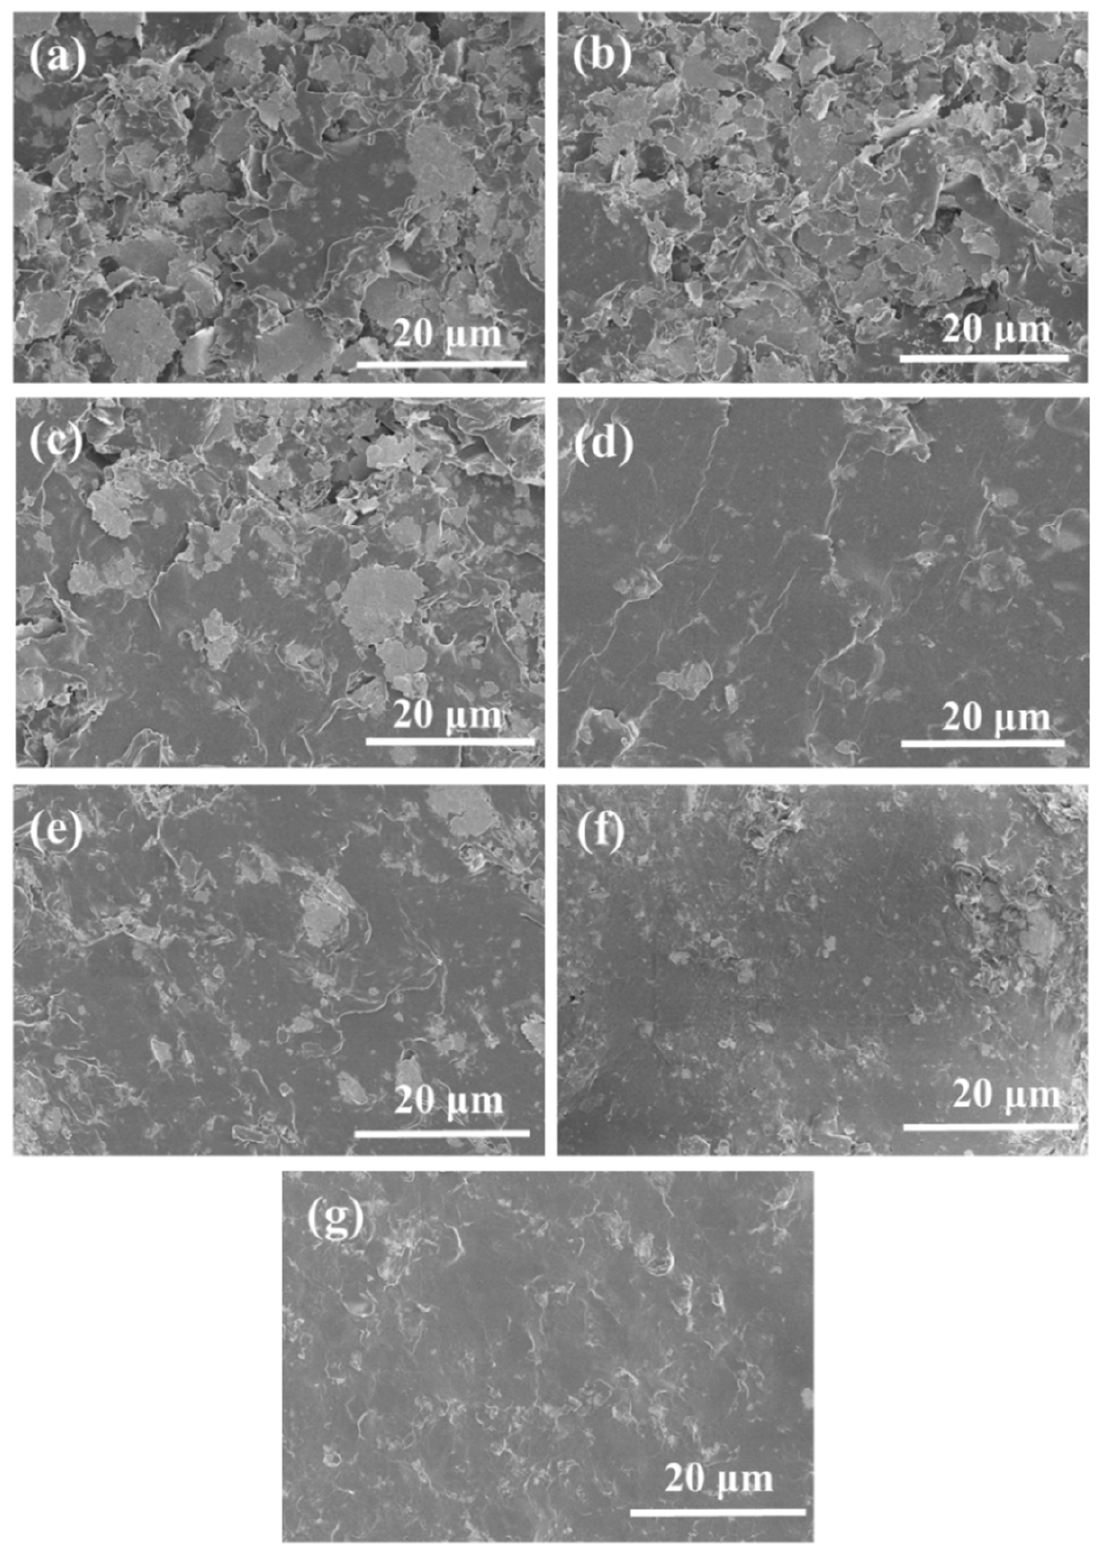
Figure 4. SEM images of the cross sections of paint film single containing different amounts of Ag MFs after curing at 60 °C: ( a ) F 10 , ( b ) F 15 , ( c ) F 20 , ( d ) F 25 , ( E ) F 30 , ( f ) F 35 and ( g ) F 40 .